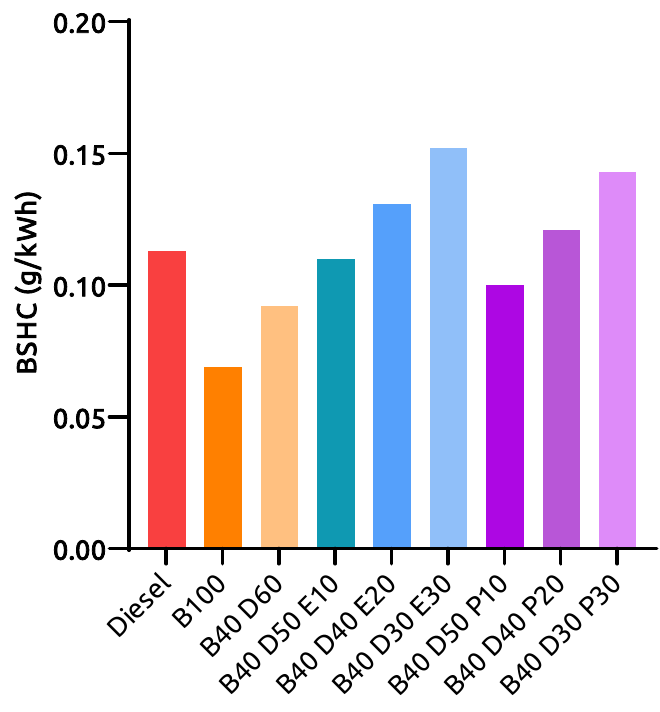
Figure 8. Brake specific hydrocarbon emissions for tested fuels at full engine load. The BSNO X values obtained for all tested fuels at 100% engine loading conditions are illustrated in Figure 9. It can be inferred that the BSNO for reference fuels such as diesel, B100, and B40D60 are 5.368 g/kWh, 5.990 g/kWh, and 5.575 g/kWh, respectively. The ethanol-based ternary blends such as B40D50E10, B40D40E20, and B40D30E30 showed 5.210 g/kWh, 5.026 g/kWh, and 4.504 g/kWh, while propanol-based ternary blends such as B40D50P10, B40D40P20, and B40D30P30 showed 5.266 g/kWh, 5.128 g/kWh, and 4.672 g/kWh, the increasing volumetric presence of alcohols in ternary blends lowers BSNO X emissions correspondingly due to the high latent heat of vaporization. A decrease of 0.0309 g/kWh, 0.447 g/kWh, and 0.903 g/kWh was noted for B40D50P10, B40D40P20, and B40D30P30, along with B40D50E10, B40D40E20, and B40D30E30, which also saw a de- crease of 0.365 g/kWh, 0.549 g/kWh, and 1.071 g/kWh, respectively, when compared to the B40D60 binary blend. The B100 was seen to give the highest BSNO X value, followed by the B40D60 and diesel with a decrement of 0.415 g/kWh and 0.622 g/kWh, respectively. Zeldovich’s mechanism [59] states that an O 2 rich mixture, elevated combustion tempera- ture, and long combustion duration are the conditions that contribute to a surge in NO formation. Compared to diesel, both B100 and B4D60 blend exhibit higher BSNO X emis- sions due to the in-fuel O 2 available in Palm biodiesel. In ternary blends, the higher latent